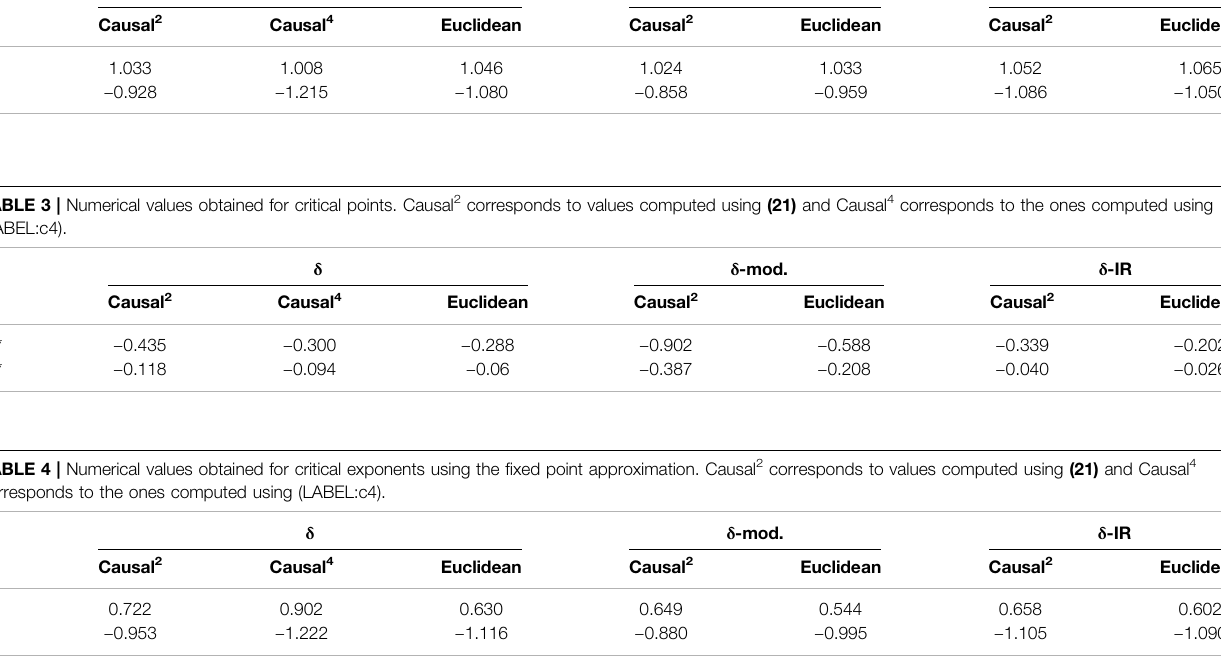
TABLE 2 | Numerical values obtained for critical exponents. Causal 2 corresponds to values computed using (21) and Causal 4 corresponds to the ones computed using (LABEL:c4). δ δ -mod.